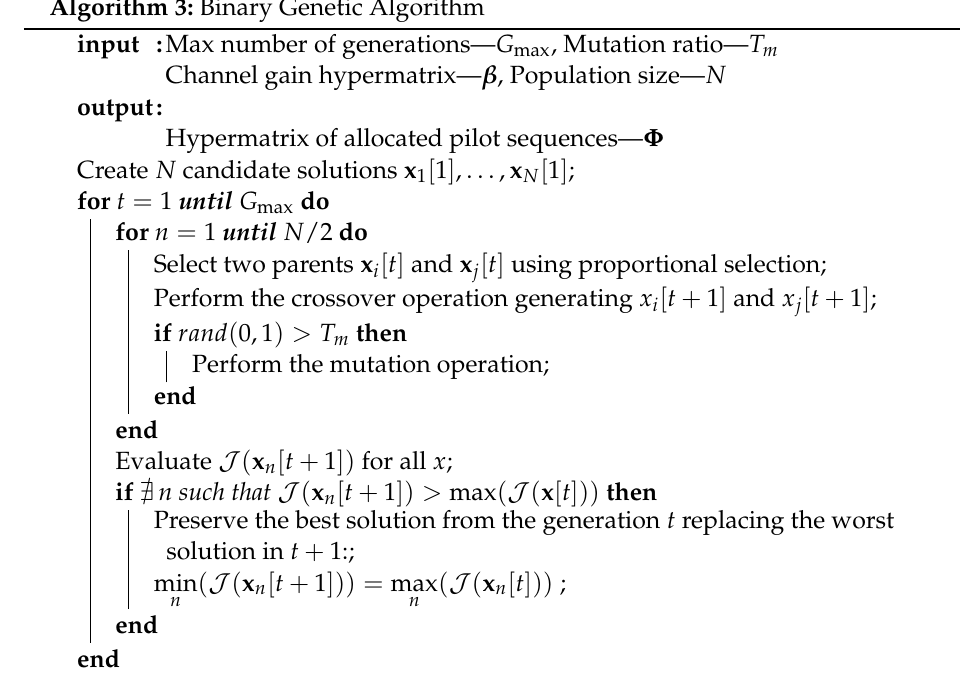
Algorithm 3: Binary Genetic